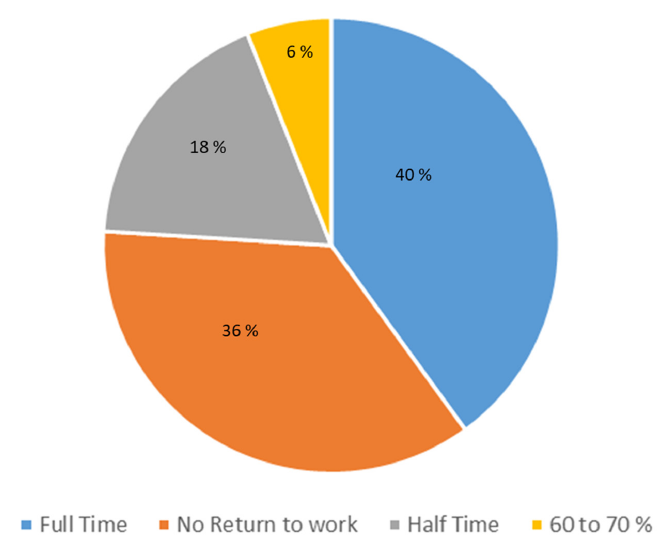
Figure 6. Patients’ ability to return to work.